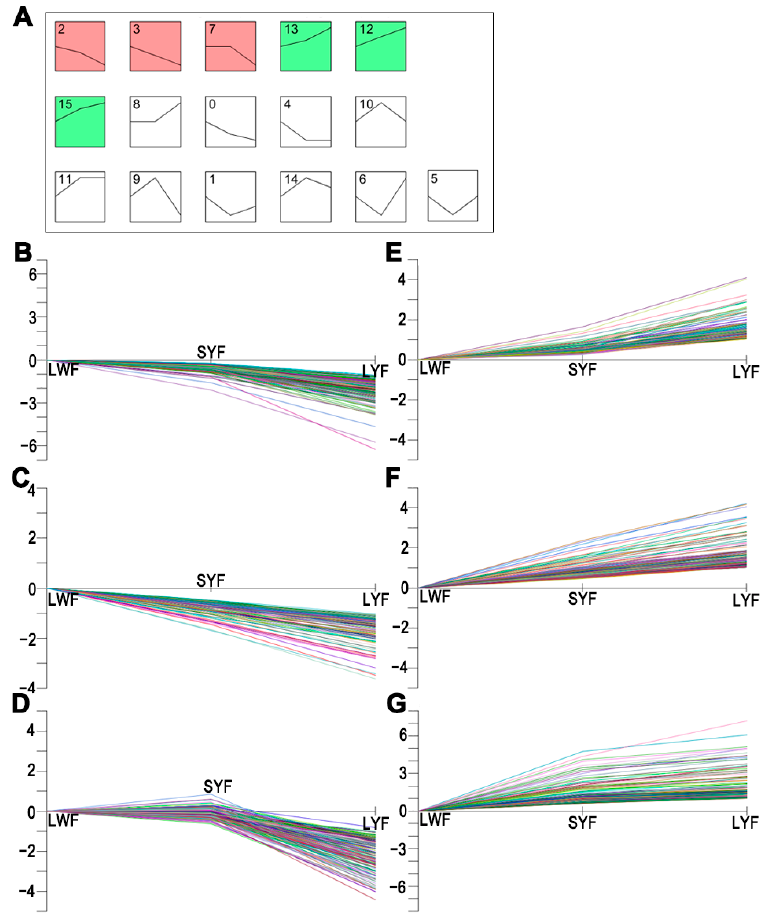
Figure 9. Gene expression dynamics profiles around follicle selection. ( A ) All mRNA expression profiles. All mRNAs could be clustered into 16 profiles, of which 6 were significant ( p < 0.05). ( B – D ) Three downregulated patterns ( p rofiles 2, 3, and 7, respectively). ( E – G ) Three upregulated patterns ( B – D ) Three downregulated patterns (profiles 2, 3, and 7, respectively). ( E – G ) Three upregulated (profiles 13, 12, and 15, respectively). patterns (profiles 13, 12, and 15,